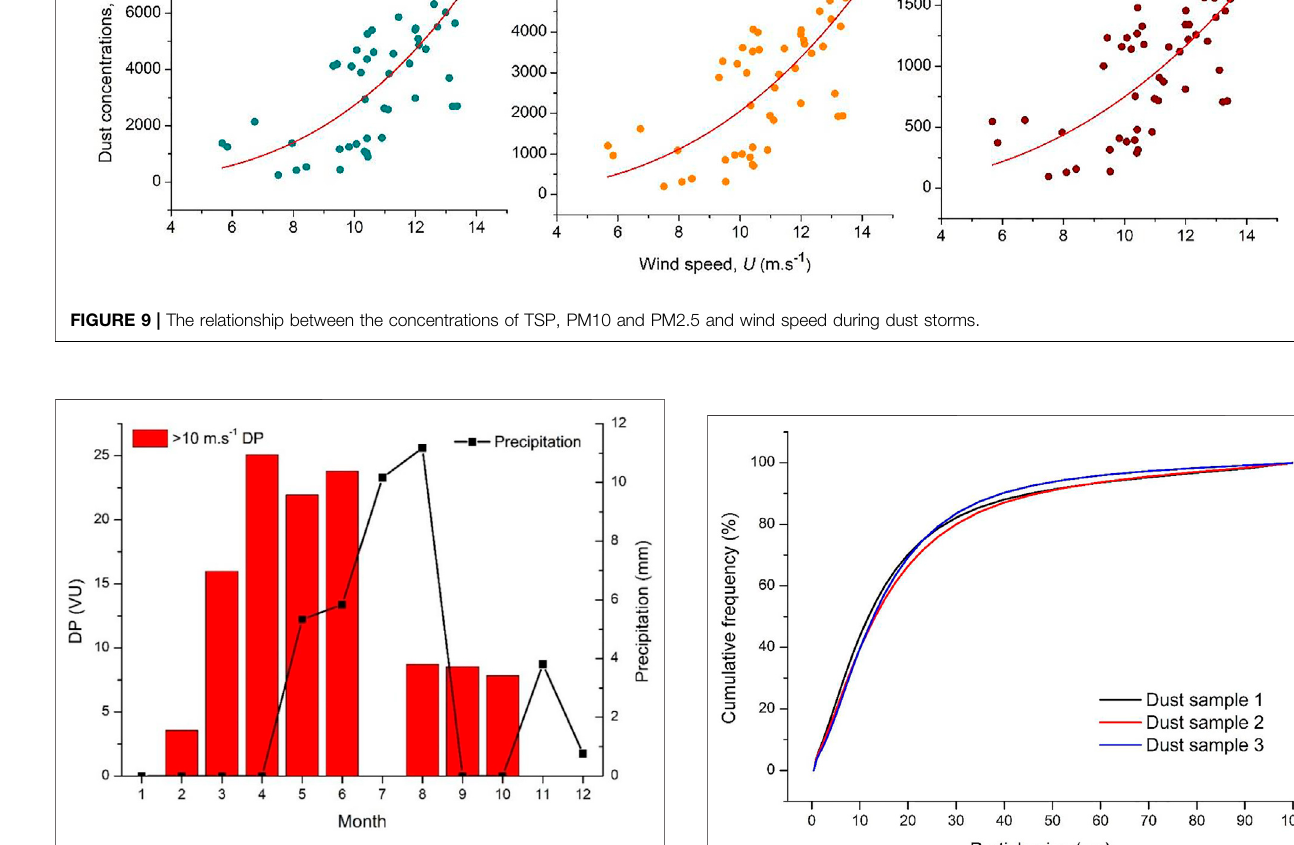
Frontiers in Environmental Science |